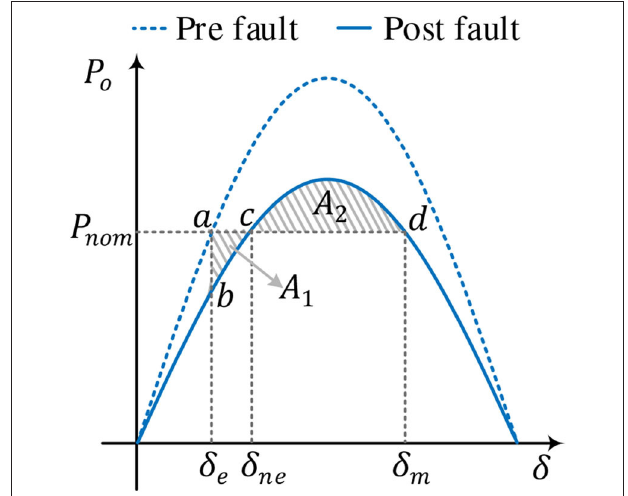
FIGURE 9 | Transient stability analysis of droop control using the equal area